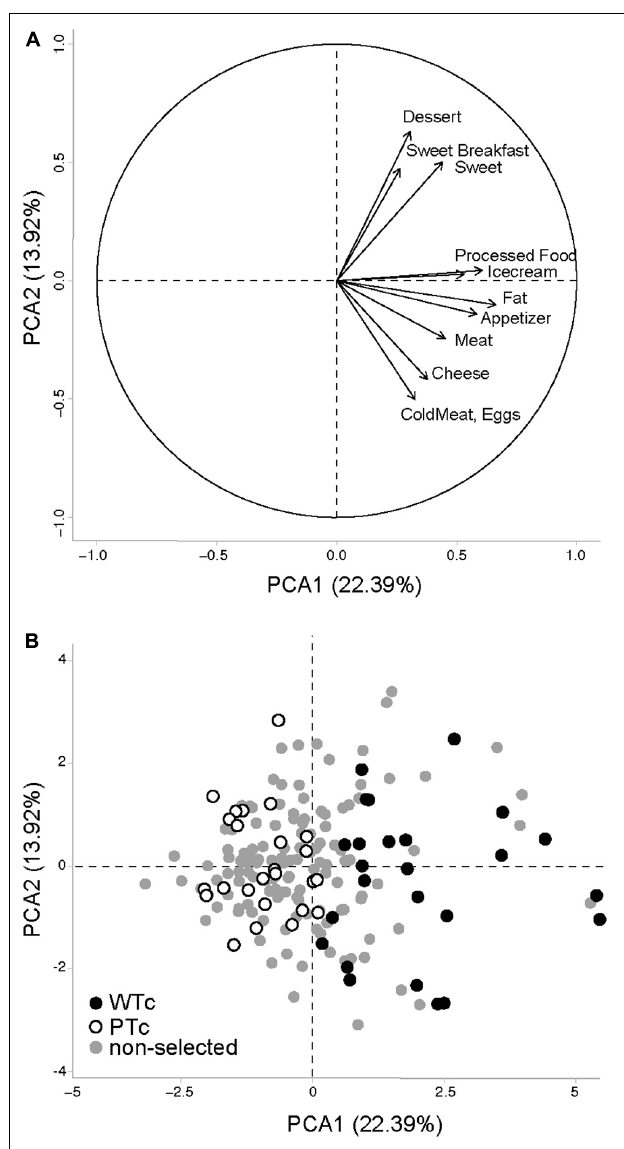
FIGURE 2 | Principal component analysis (PCA) performed on the Food Frequency Questionnaire data obtained from 178 volunteers, with the (A) projection vectors of the different food items included in the questionnaire focused on Western-type foods, and (B) individual values projected on the first two axes of the PCA. WTc, Western-type consumers ( N = 25) with the highest values for PCA1 among the 50 volunteers selected for the brain imaging study. PTc, prudent-type consumers ( N = 25) with the lowest values for PCA1 among the 50 volunteers selected for the brain imaging study. The first two axes of the PCA bear, respectively, 22.39 and 13.92% of the population